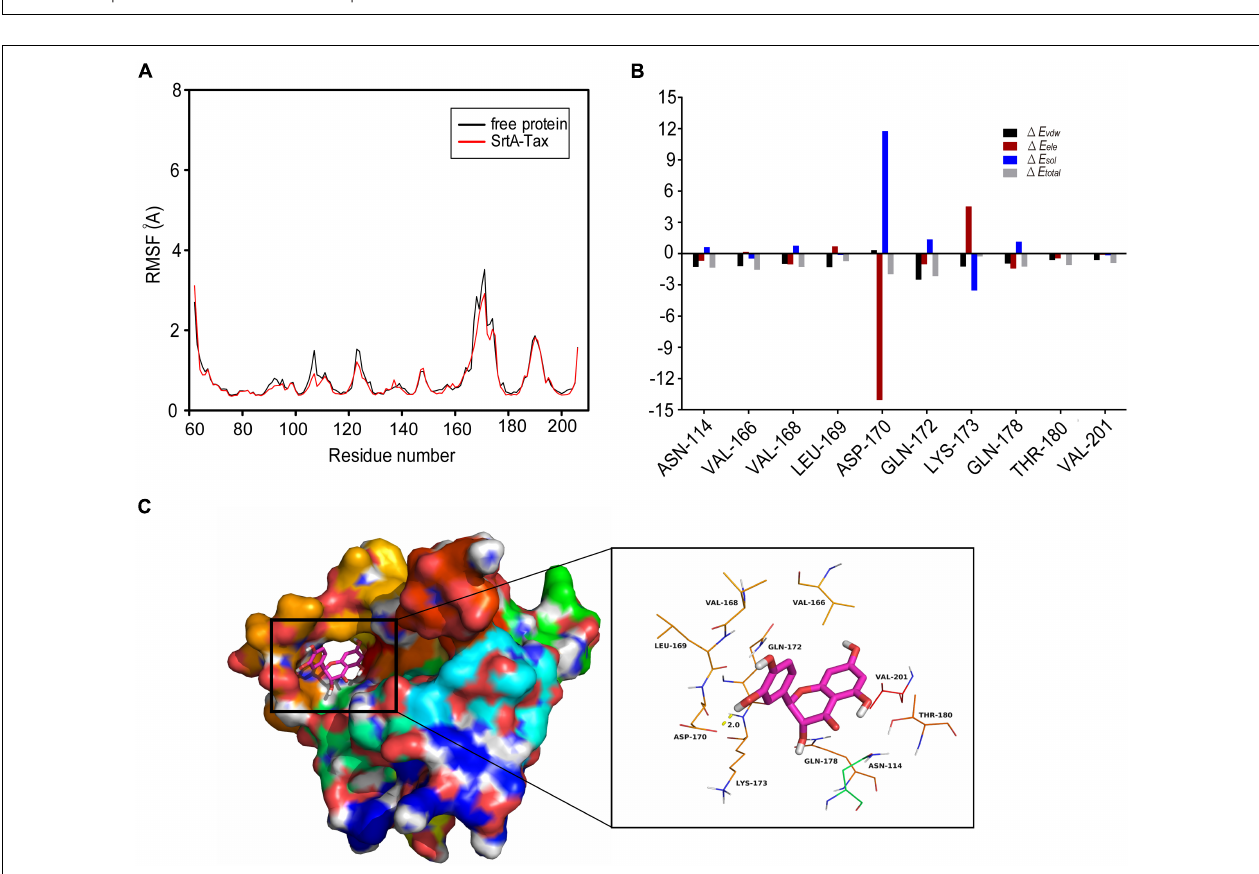
FIGURE 4 | Expression of SrtA in the presence of Tax and the interaction of different concentrations of Tax with SrtA. (A) Western blot analysis of SrtA protein from S. aureus treated with various concentrations of Tax and grayscale analysis of SrtA protein bands. (B) LSPR analysis verified the binding affinity of Tax with SrtA. Error bars represent means ± SD of three replicates. *** P < 0.001 calculated with a two-tailed Student’s t -test.